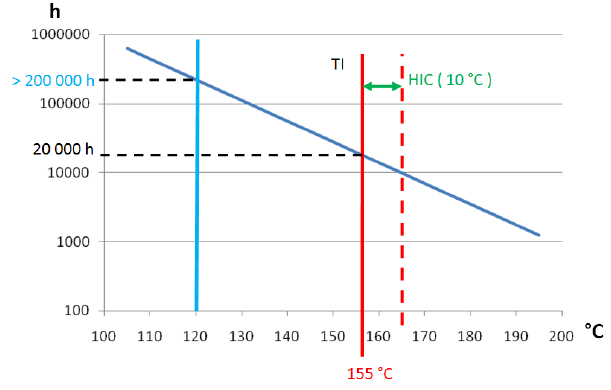
Figure 5. The thermal endurance graph is the basic graph that is able to provide an assessment of the insulation lifespan. The graph is linked to Class F insulation. By limiting the operating temperature, i.e., 120 °C, lifespan reaches 200,000